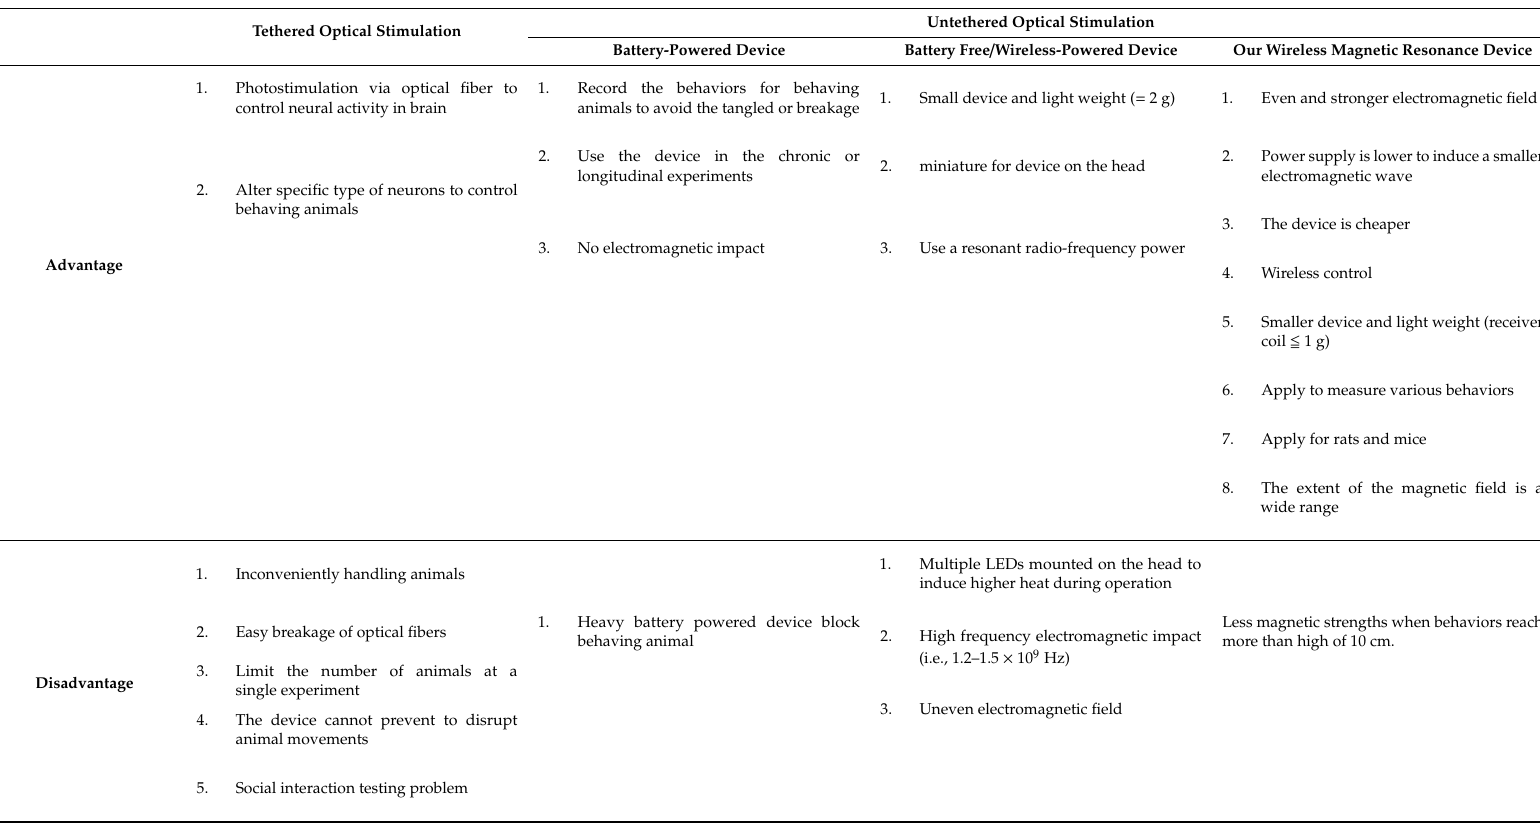
Table 1. Comparison of the advantages and disadvantages between the tethered and untethered optical stimulation